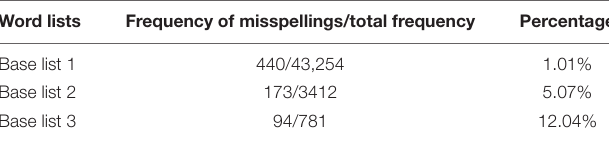
TABLE 8 | Percentage of misspellings per base